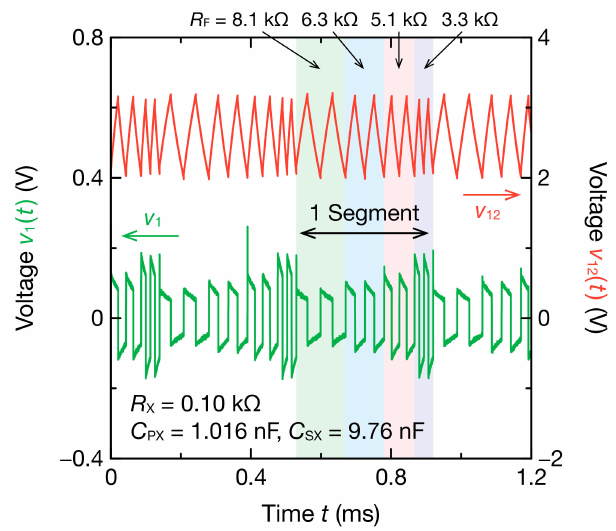
Figure 4. Four-mode oscillation waveforms of v 1 ( t ) and v 12 ( t ) obtained through the mode-switching nonsinusoidal oscillator. R X , R PX , C PX , and C SX were set to 0.10 k, 0 Ω , 1.016 nF, and 9.76 nF, respectively. The oscillation frequency was switched every two cycles of each R F . The DFT analysis was performed on the oscillation waveforms of the second half of two cycles.